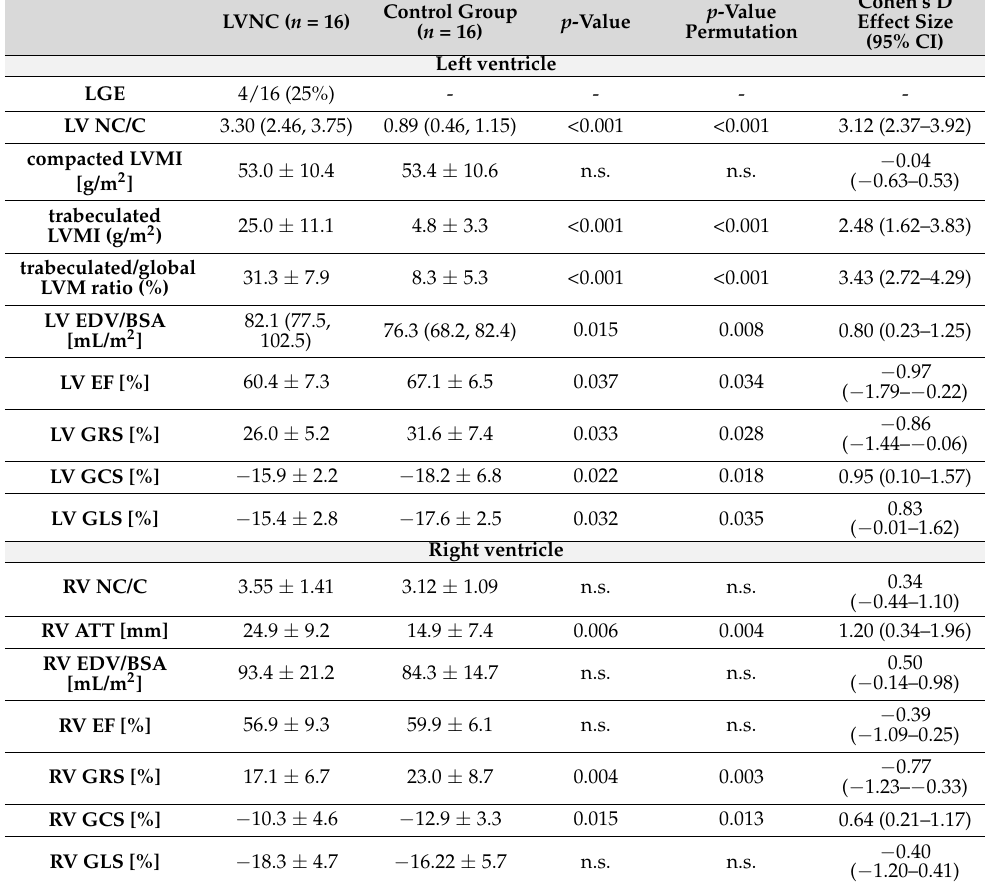
Table 2. Comparison of left and right ventricular morphology and function assessed in CMR between patients with LVNC and the control group. LGE indicates late gadolinium enhancement; LV, left ventricle; NC/C, noncompacted to compacted ratio; LVMI, left ventricular mass index; LVM, left ventricular mass; EDV, end-diastolic volume; BSA, body surface area; EF, ejection fraction; GRS, global radial strain; GCS, global circumferential strain; GLS, global longitudinal strain; RV, right ventricle; ATT, apical trabeculation thickness. LVNC ( n =